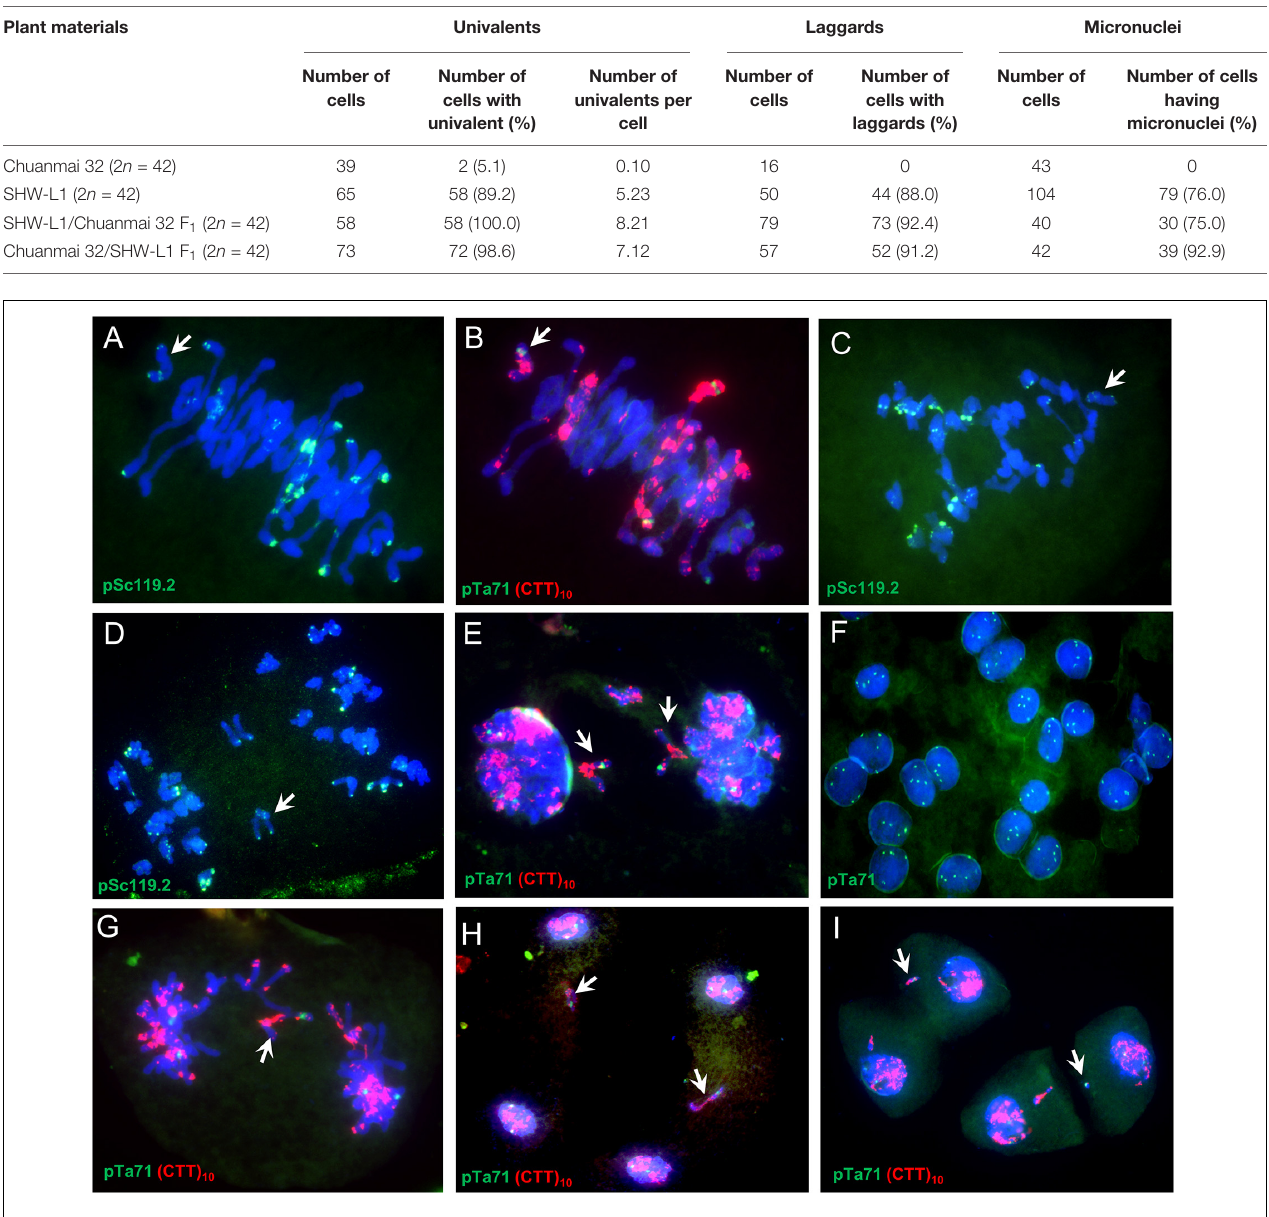
FIGURE 3 | Meiosis in a SHW-L1 monosomic 6B plant. (A,B) Metaphase I; (C) Anaphase I; (D,E) Ana-/telophase I; (F) Dyads, signals showing secondary constrictions of chromosome 1B, 6B, and 5D; (G,H) ; Anaphase II to telophase II; (I) Tetrads. White arrows indicate chromosome 6B or fragments